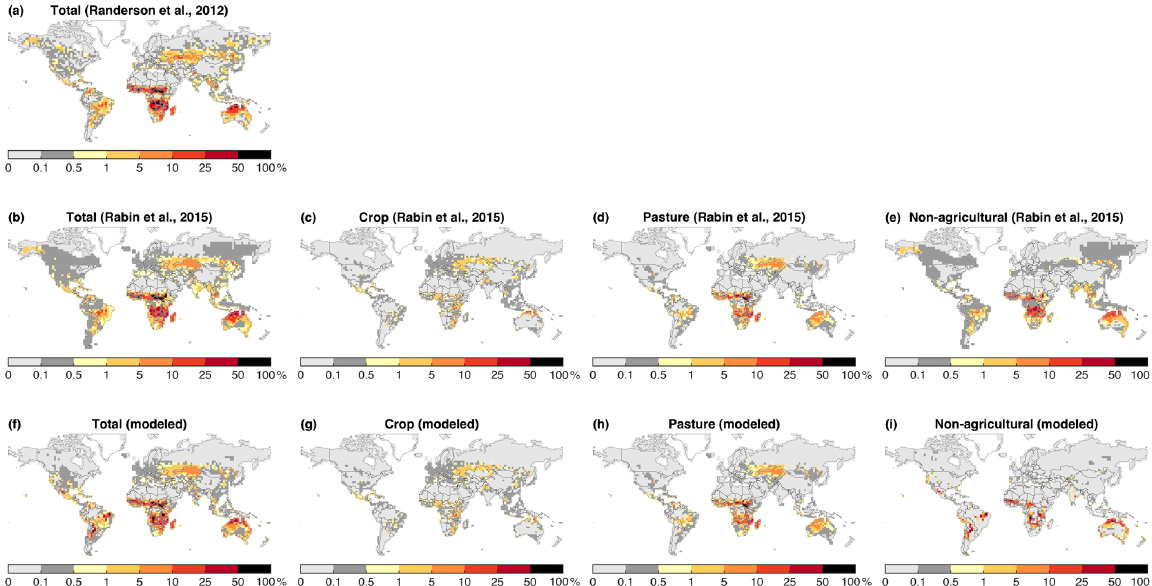
Figure 5. Mean annual burned fraction over 2001–2009. (a) : from GFED3s (Randerson et al., 2012); (b–e) : observational estimates from unpacking analysis; (f–i) : model-estimated. ( i is identical to Fig.